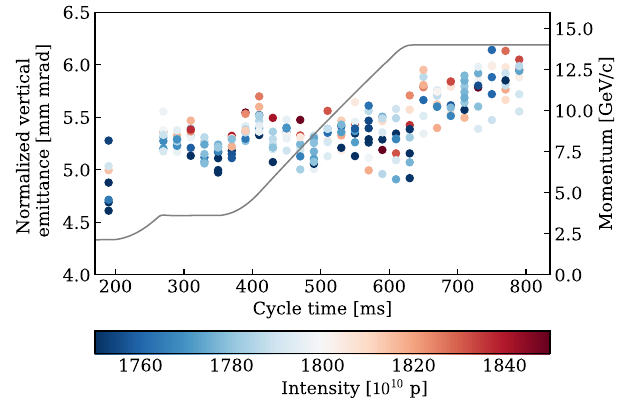
Þ ¼ aN þ b , p p the total p